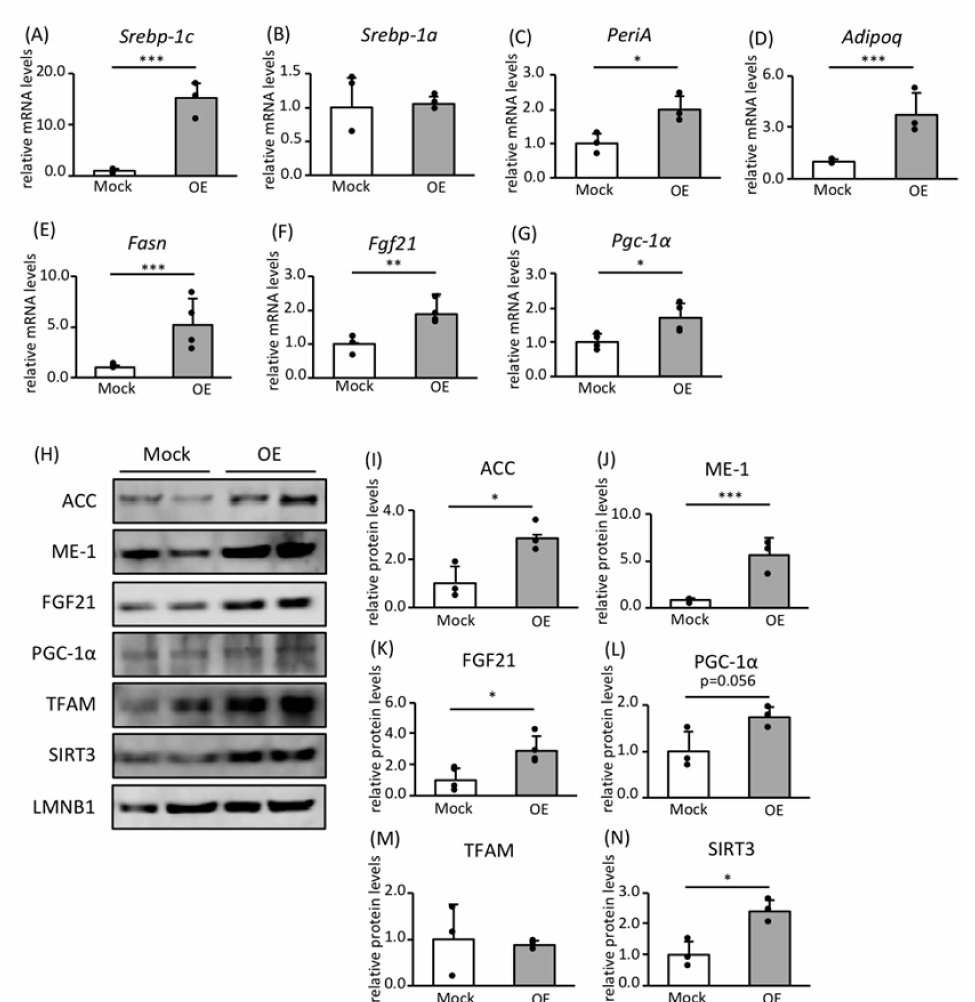
Figure 2. The e ff ects of SREBP-1c overexpression on the expression of genes and proteins involved in fatty acid (FA) biosynthesis and mitochondrial biogenesis in mature 3T3-L1 adipocytes. Control and SREBP-1c OE preadipocytes were di ff erentiated into mature adipocytes in four separate dishes